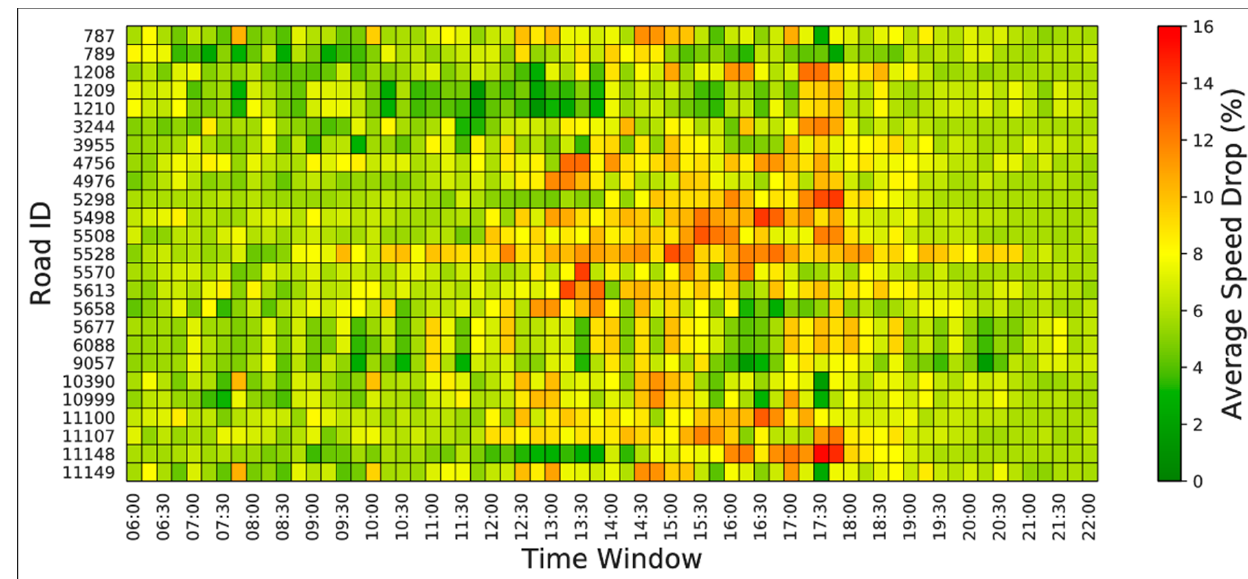
Figure 3. The STC matrix of the 25 representative roads in Jakarta.